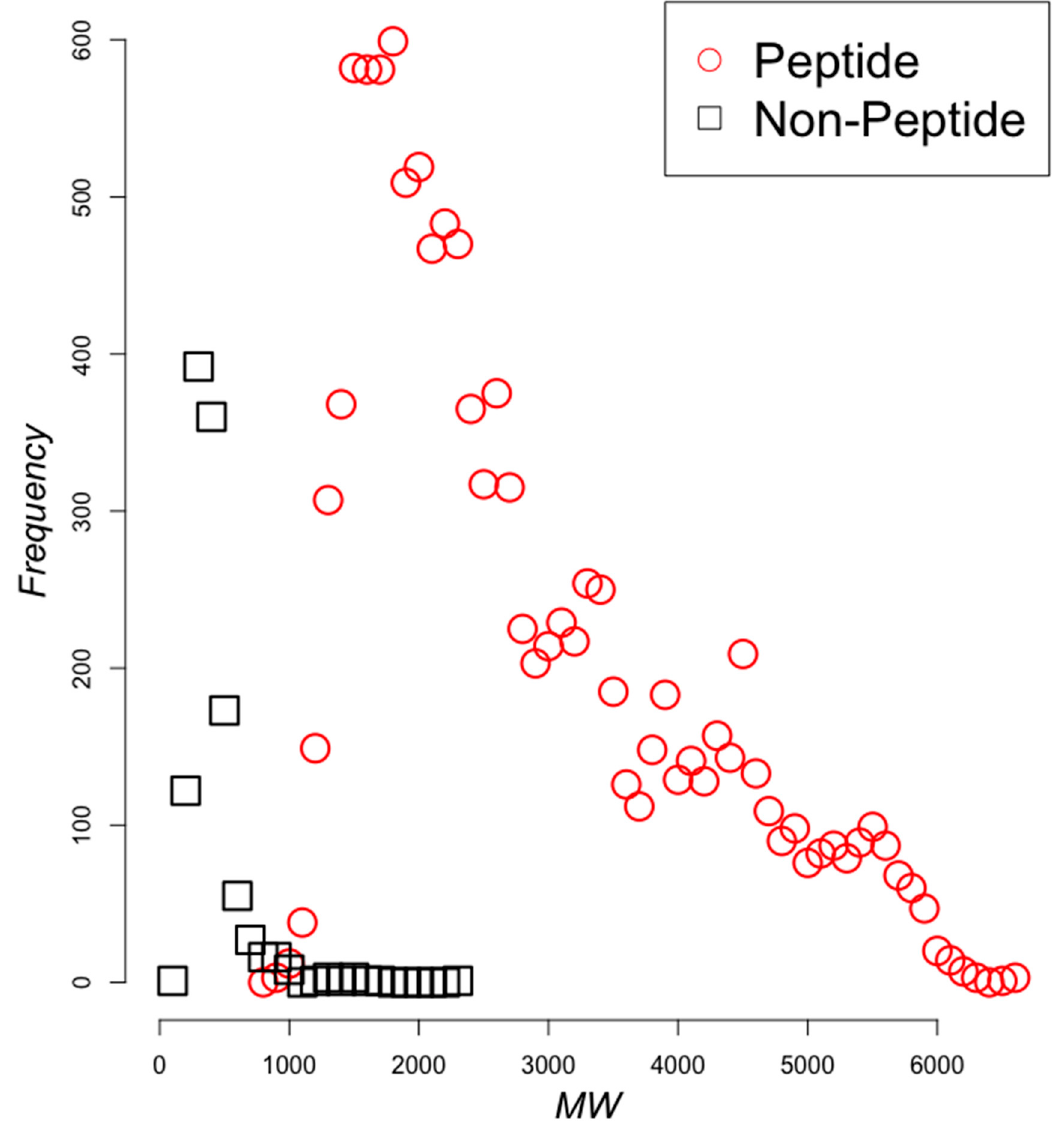
Figure 3. Molecular weights comparison between peptides and non-peptides in the training set. Red squares represent peptides and non-peptides are black squares. The y-axis presents the observed frequency of molecules within the specified range of molecular weights (x-axis). Molecular weights were accumulated in bins of size 100 Da (0–100, 101–200, ... , 6401–6500, 6501–6600). Thus, every symbols correspond with the number of molecules observed every range of 100 Da in molecular weight.